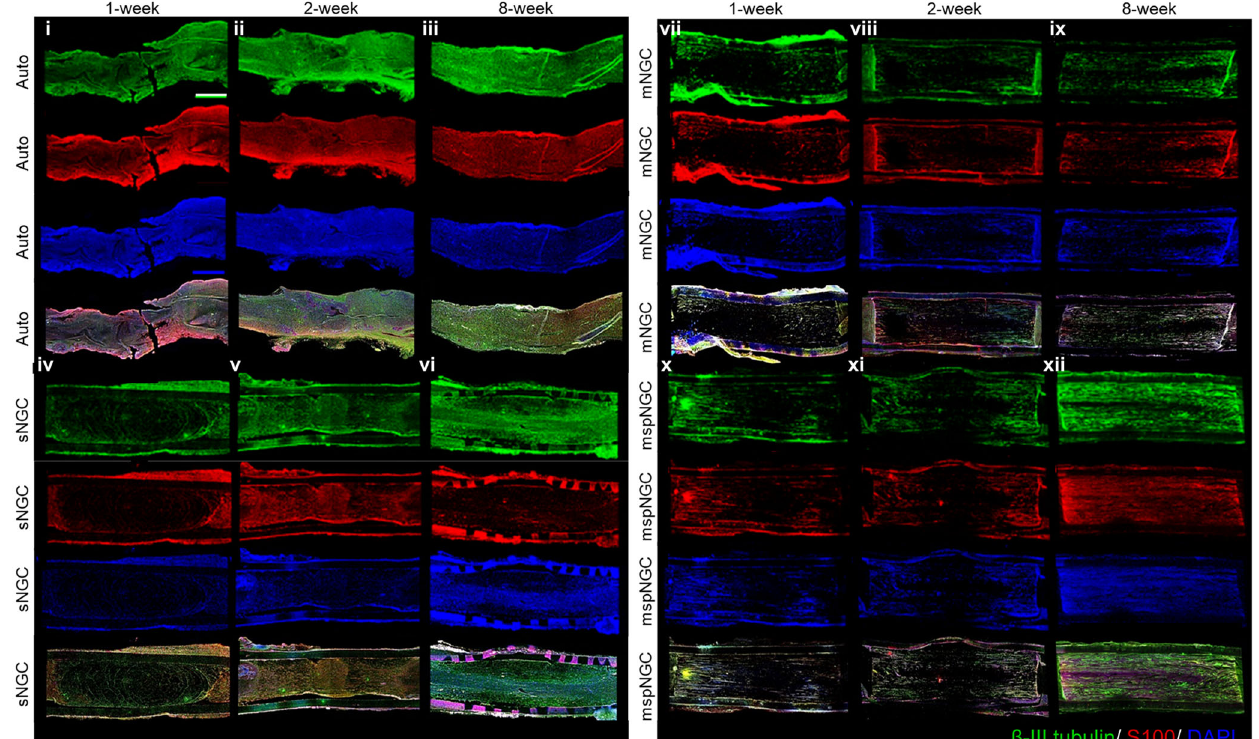
Fig. 3 Nerve regeneration mediated by the produced NGC. Fluorescence micrographs of longitudinal sections of implant groups, showing neuronal regrowth along channels in i – iii autograft, iv – vi sNGC, vii – ix mNGC, and x – xii mspNGC. Green, red, and blue represent the expressions of β -III tubulin, S100, and DAPI, respectively. Scale bar indicates 1